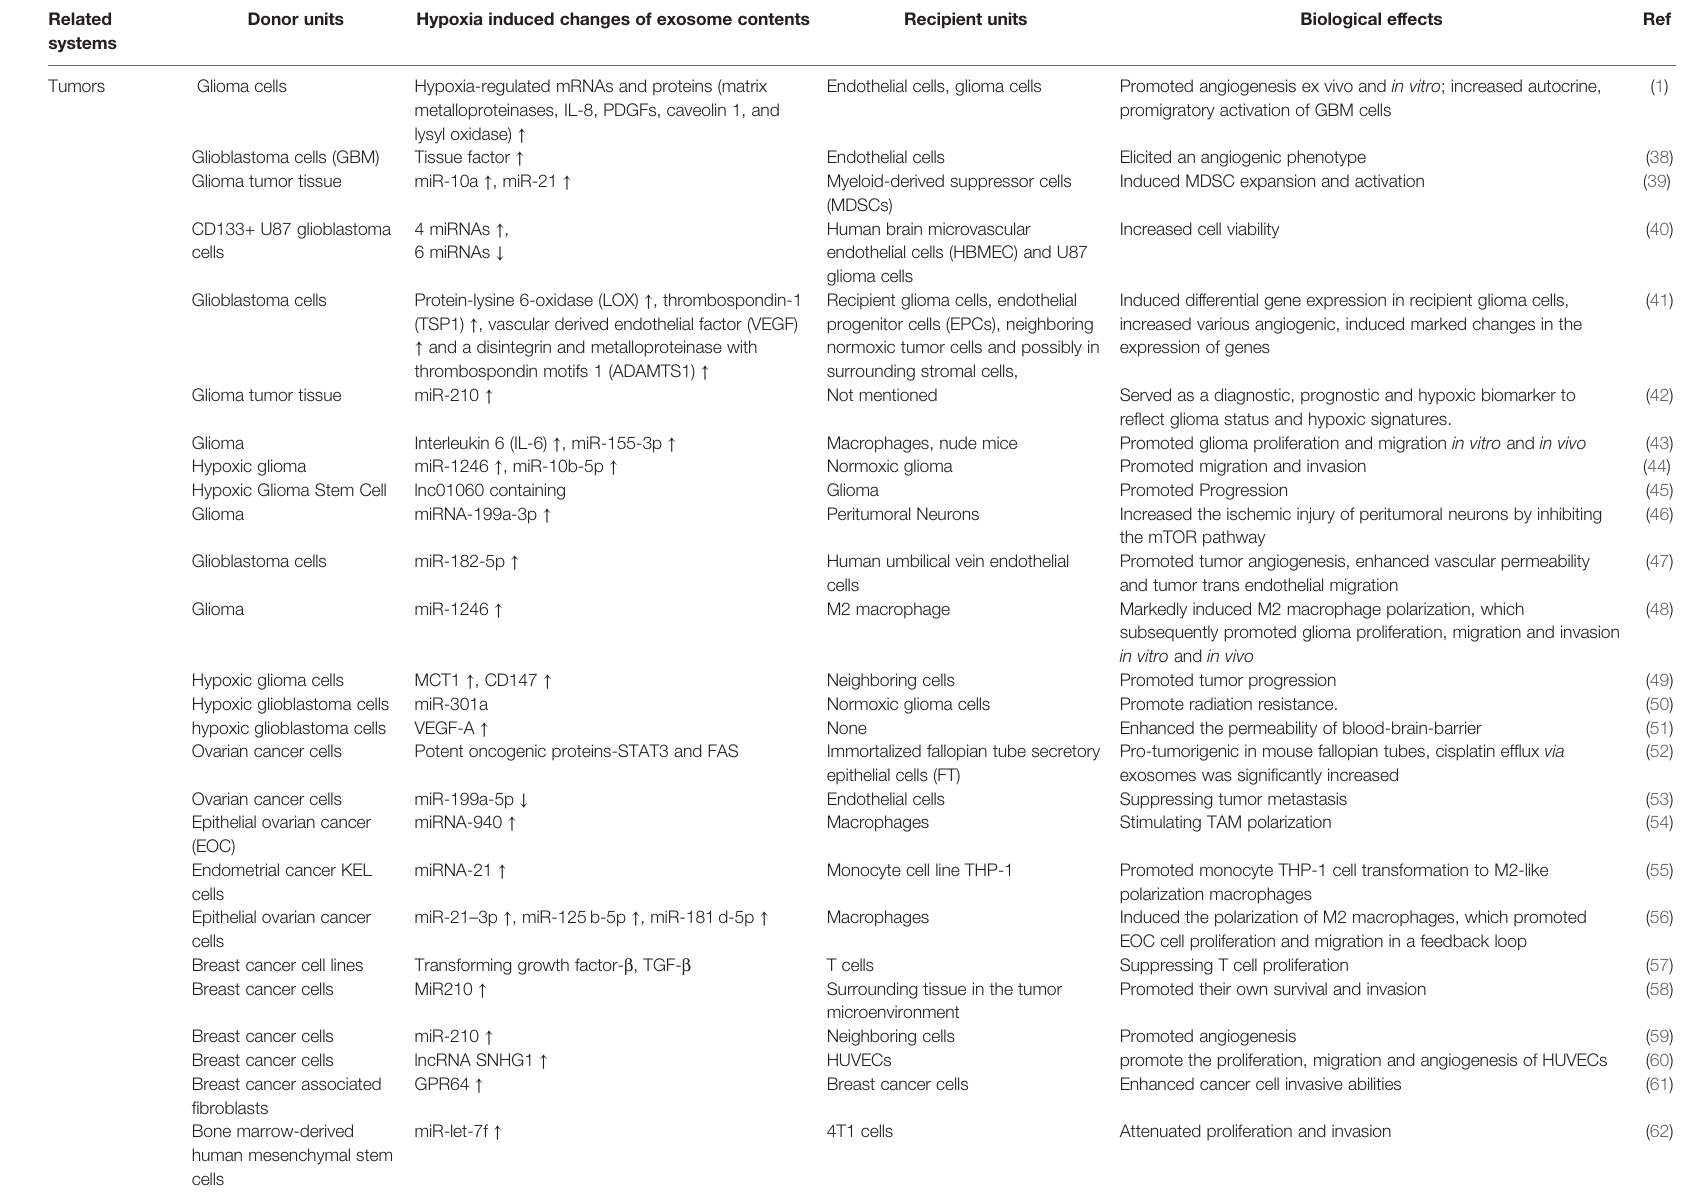
TABLE 1 | Summary of hypoxia induced changes of exosome cargos from different donor units to their corresponding target recipient units, and leading to different biological effects. Related